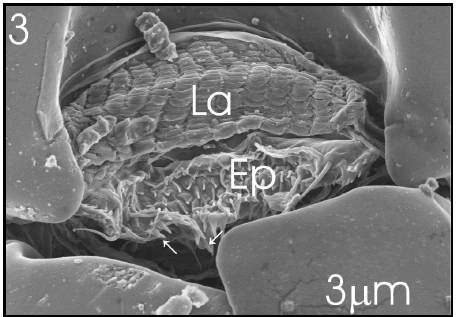
Fig. 3. The epipharynx (Ep) with its dentate struc- tures (arrows) appeared as a separate structure underlying the labrum (La).